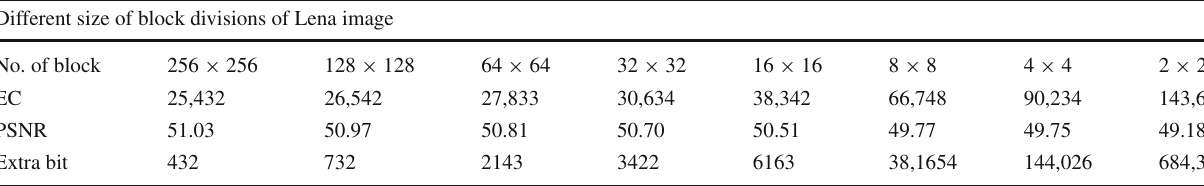
Table 1 Evaluation of the proposed scheme recital with different size block divisions Different size of block divisions of Lena image No. of block